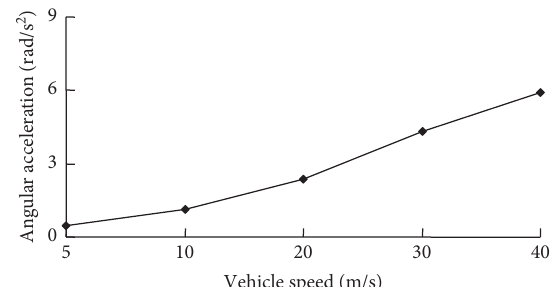
Figure 19: The variation curve of peak values of pitching vibration accelerations of the vehicle body.